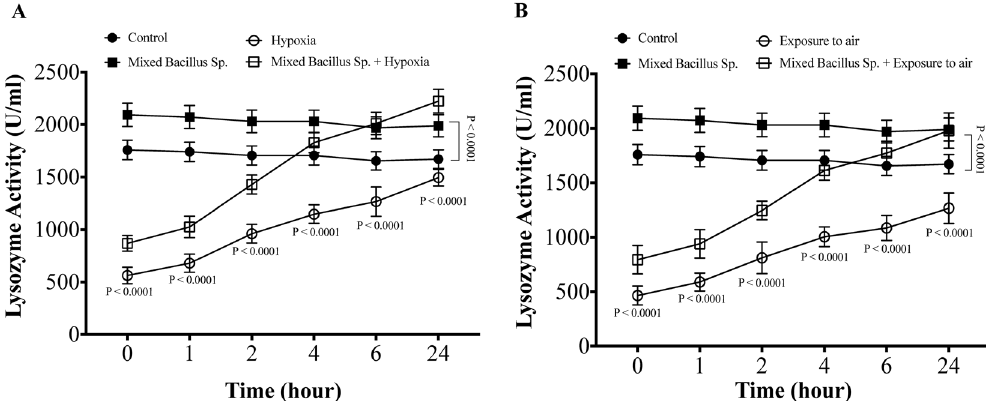
Figure 1. A mixed Bacillus Species enhances the lysozyme activity in Yellow perch subjected to experimental hypoxia and exposure to air stressors. Plasma lysozyme activity in Yellow Perch that subjected to ( A ) hypoxia and ( B ) air exposure stress over 24 h. Two-way Repeated measure ANOVA followed by comparing mixed Bacillus spp + stressed group to stressed groups was applied at two-tail significance level (P < 0.05). n = 9/group. Data represented in mean ±